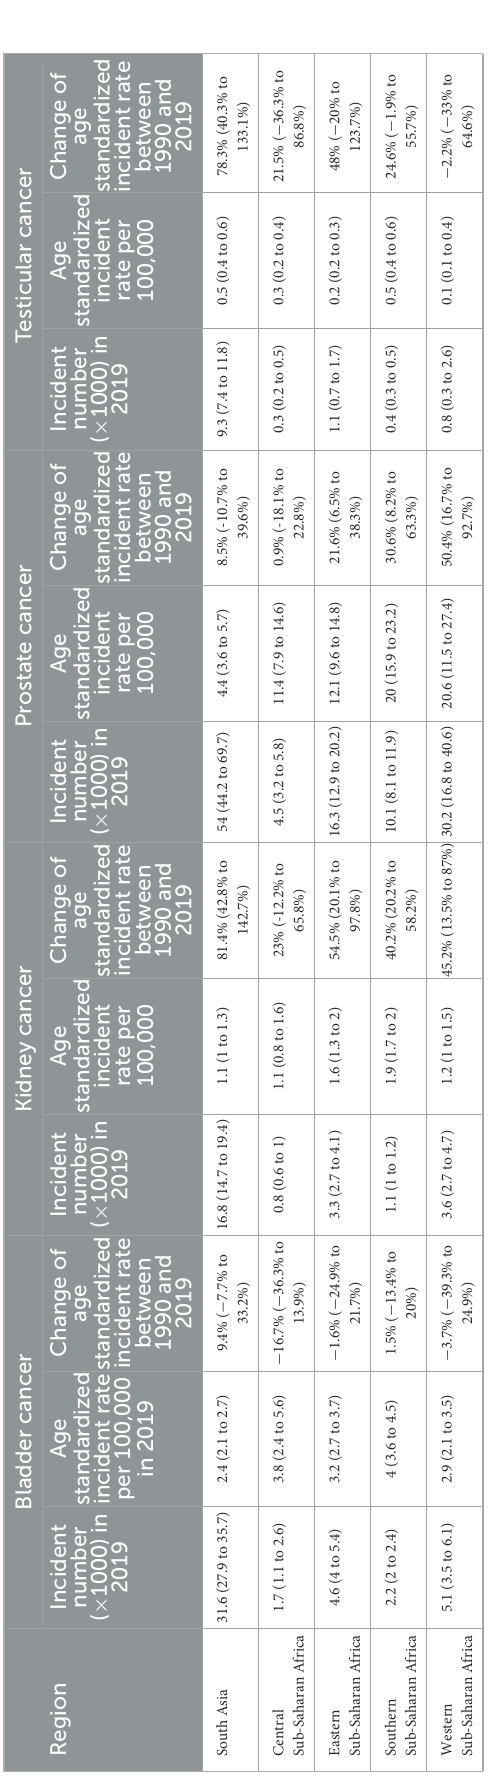
Figure 6; Supplementary Figure 11S show the risk factors for the ASMR of bladder, kidney, and prostate cancer in 2019. Smoking was a risk factor for mortality of all three cancers and was the leading risk factor for bladder cancer, and the only risk factor for prostate cancer. High fasting plasma glucose was another risk factor for bladder cancer and the trend of ASMR and ASDR caused by high fasting plasma glucose increased slightly in the past 15 years. For kidney cancer in both sexes, a high body-mass index